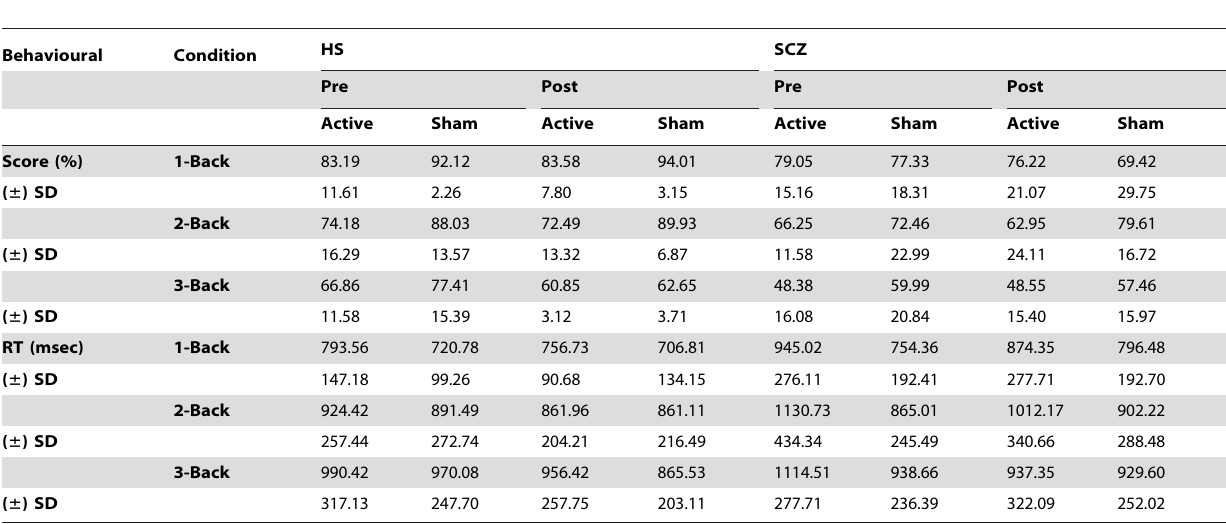
Table 3. Working memory (WM) behavioural performance (%) and reaction time (RT; msec) during the N-back in healthy subjects (HS) versus patients with schizophrenia (SCZ) pre-post either active or sham rTMS ( 6 ) 1 standard deviation pre-post rTMS.